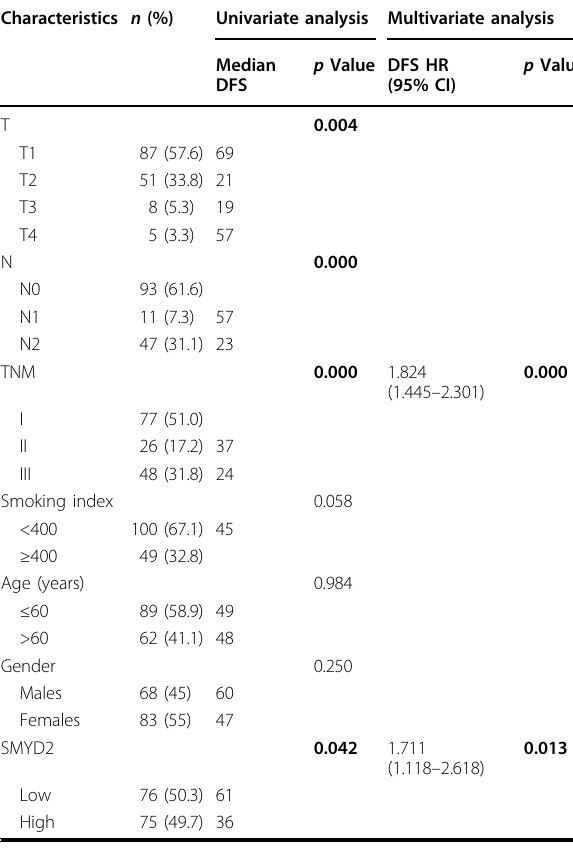
Table 1 Correlation analysis between SMYD2 level and clinical – pathological characteristics of LUAD patients.